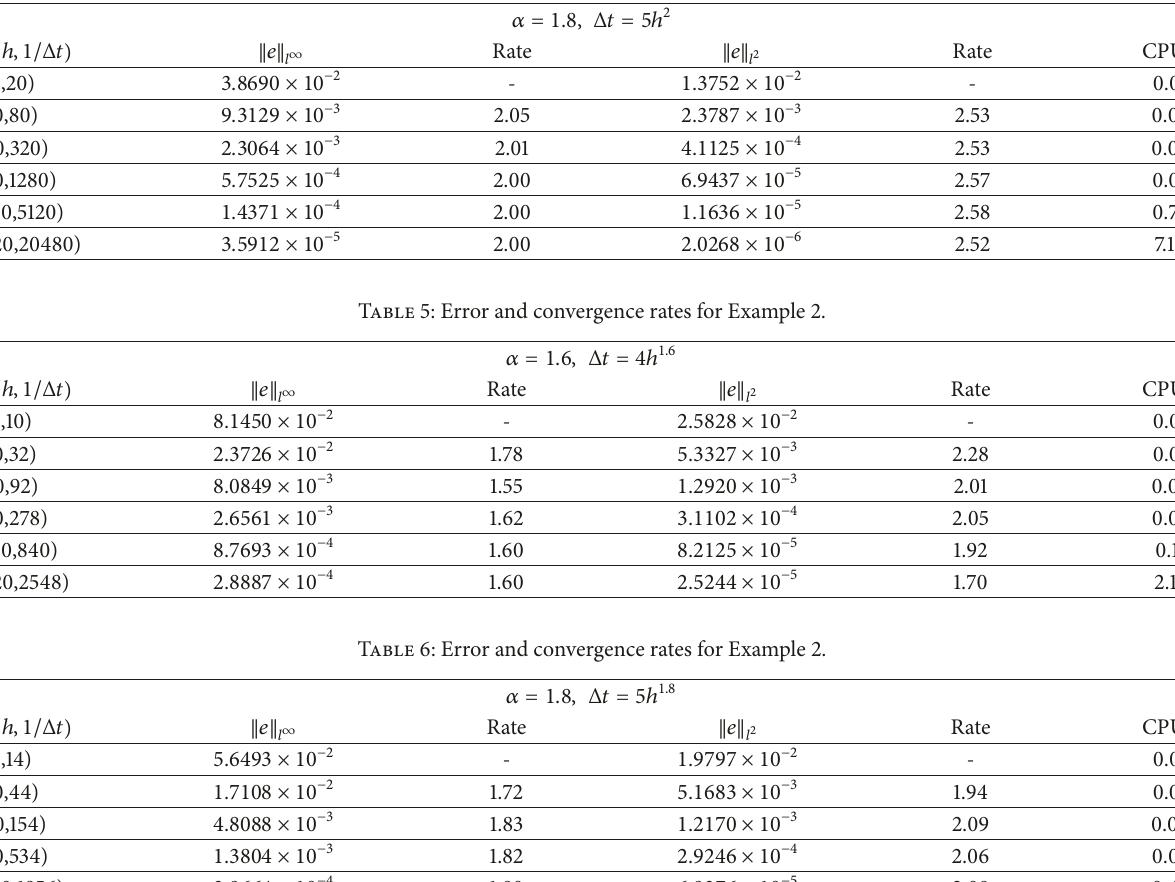
Table 4: Error and convergence rates for Example 1.